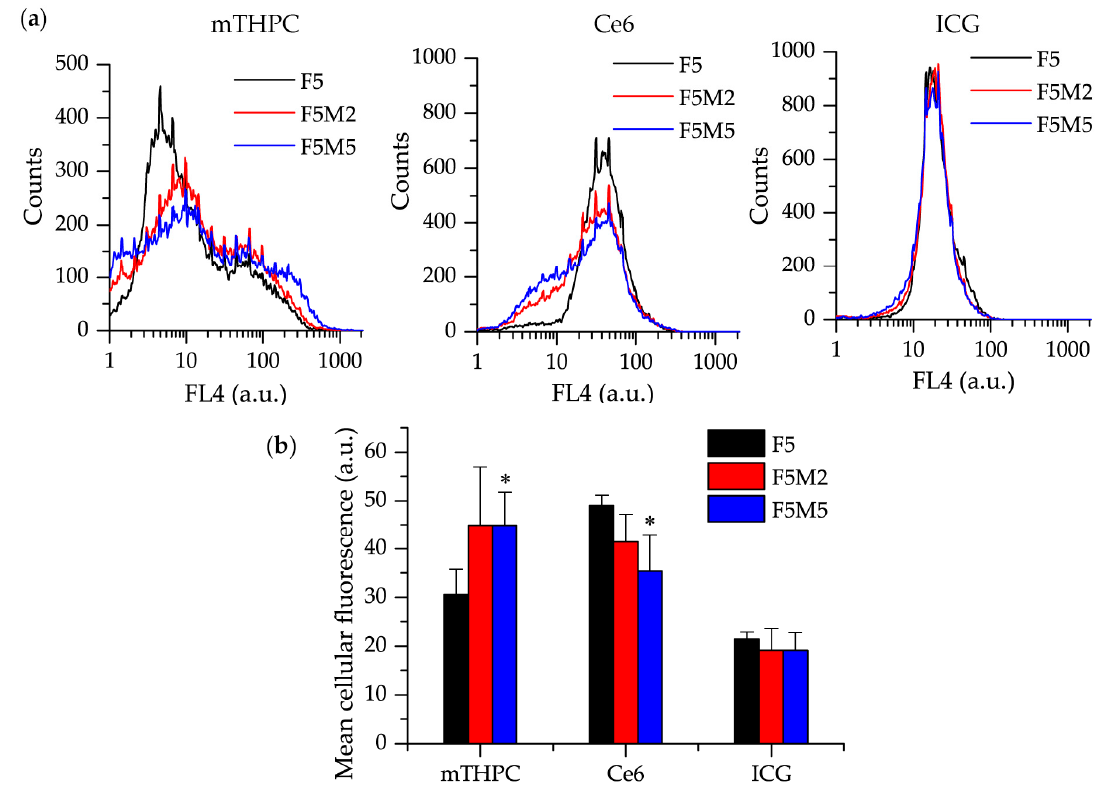
Figure 6. ( a ) The comparison between the distribution profiles of mTHPC, Ce6 (4.5 µM), and ICG (40 µ M) in FaDu (black), FaDu:MeWo 5:2 (red) and FaDu:MeWo 5:5 (blue) spheroids after 24 h incubation. ( b ) The mean fluorescence intensity of the drugs in F5, F5M2 and F5M5 spheroid cells, after 24 h incubation with mTHPC (4.5 µ M), Ce6 (4.5 µ M) and ICG (40 µ M). *: statistically significant ( p < 0.05) difference compared to FaDu homospheroids samples.